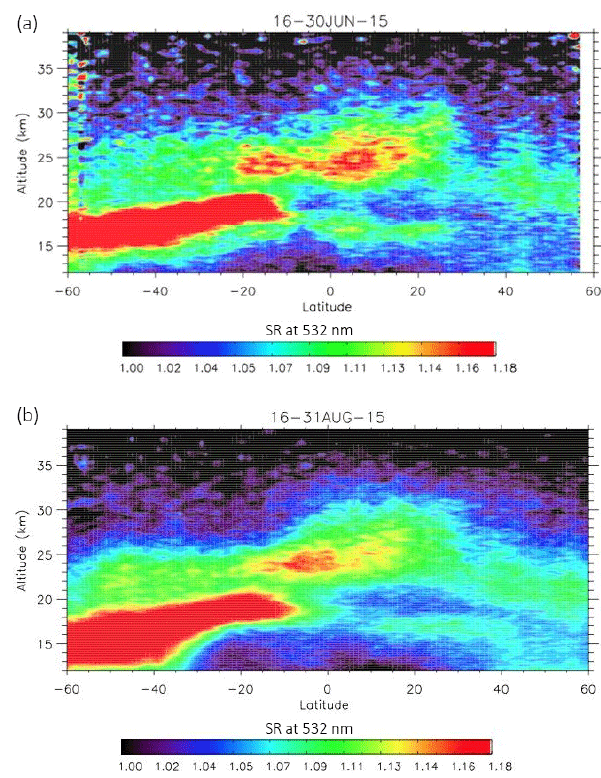
Figure 5. Half monthly mean of the zonal scattering ratio at 532nm on (a) 16–30 June (2 months after eruption) and (b) 16–31 August (4 months after eruption).